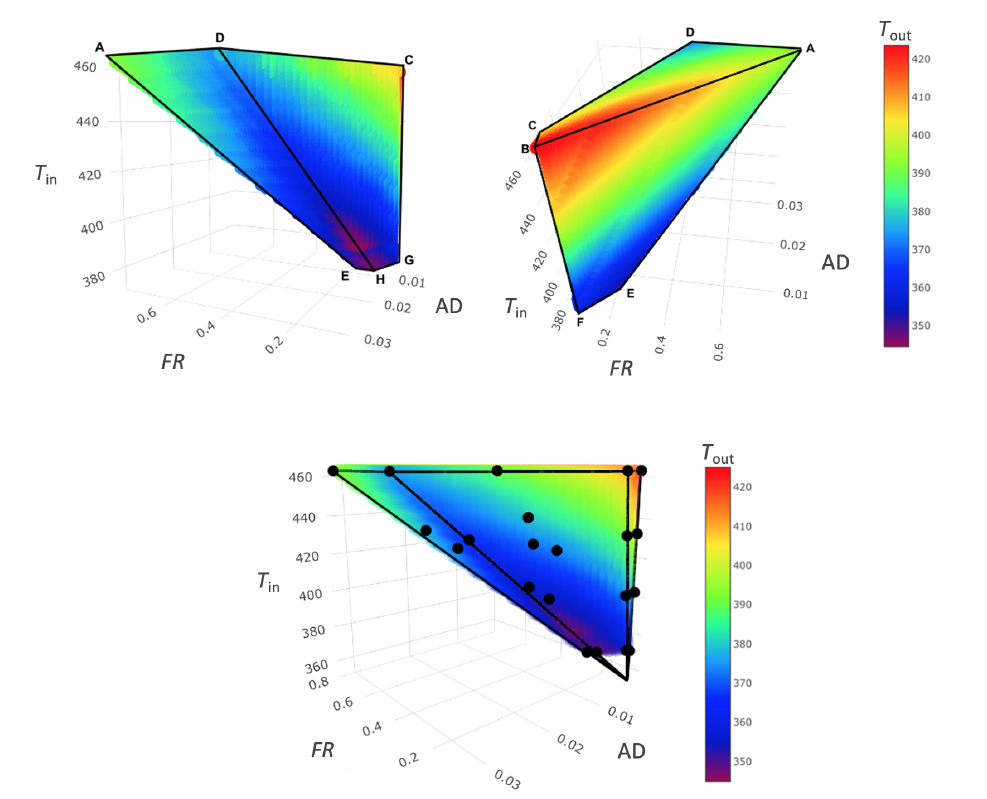
Figure 6. Design space volume and iso-level curve of T out , created with the thermodynamic model.